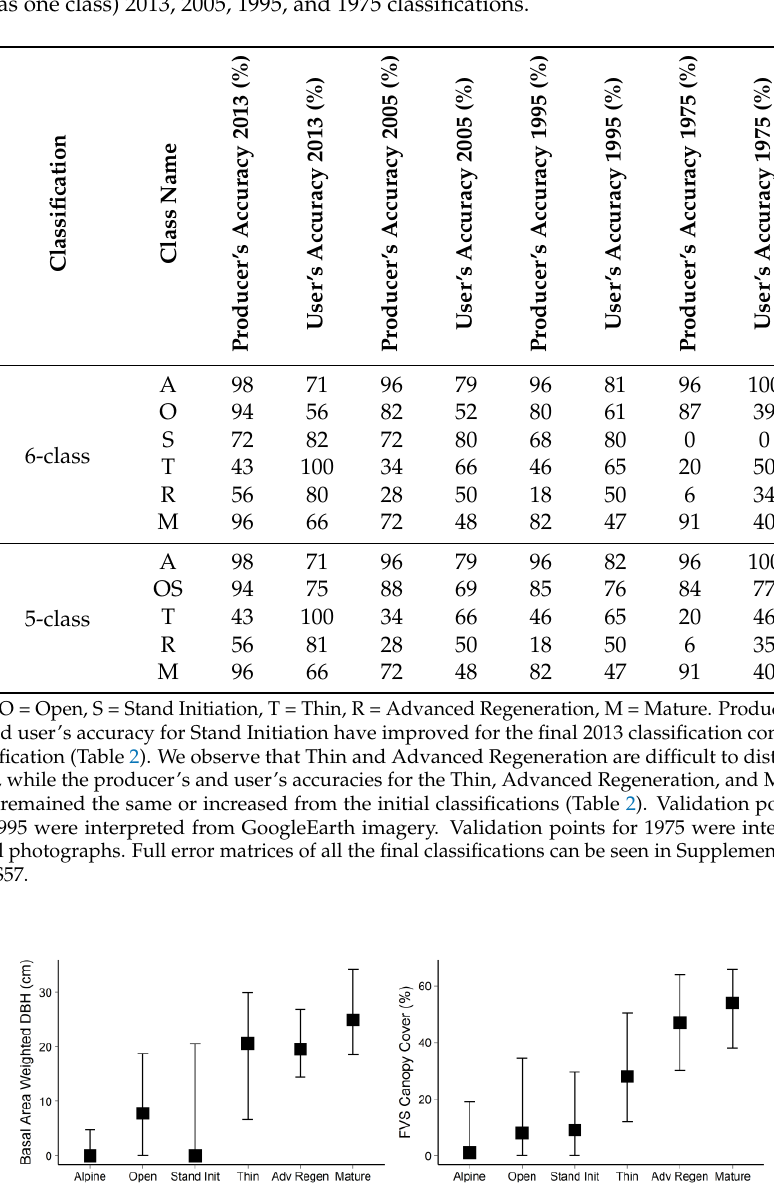
Table 4. Producer’s and User’s accuracies for the final 6-class and 5-class (Open and Stand Initiation combined as one class) 2013, 2005, 1995, and 1975 classifications.